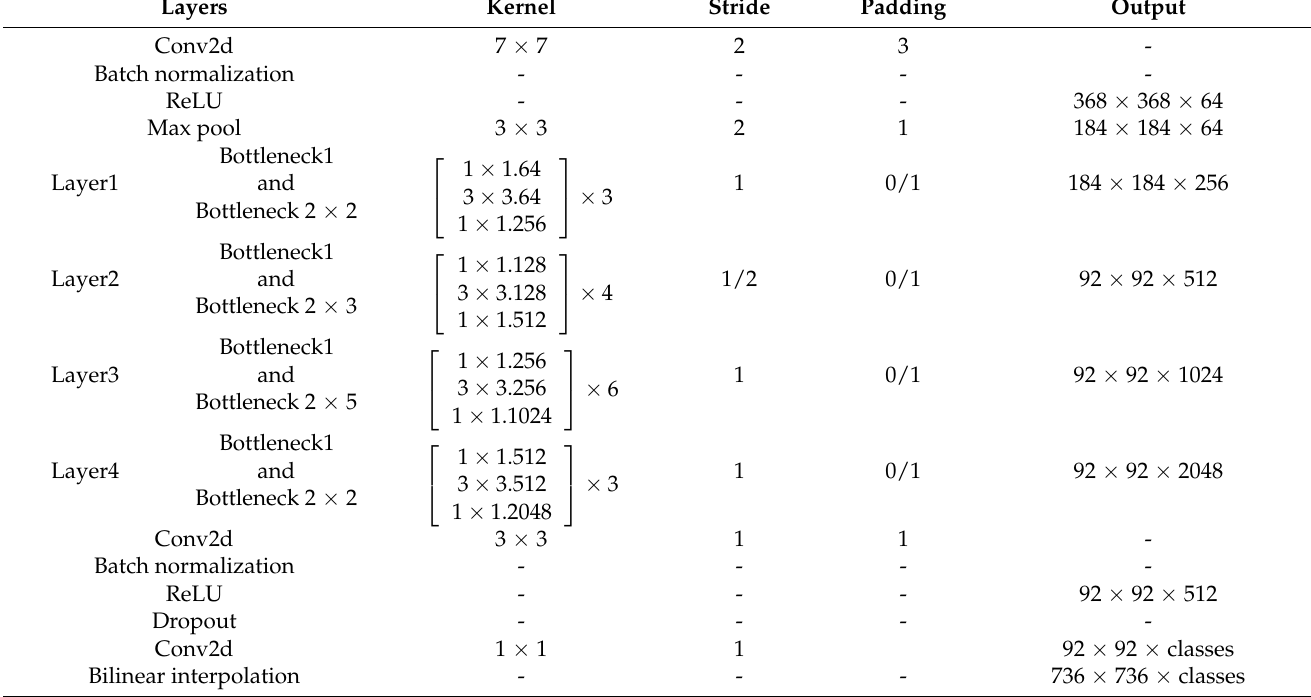
Table 1. Layers of Fully Convolutional Networks (FCN)-ResNet50 used for sand data analysis.